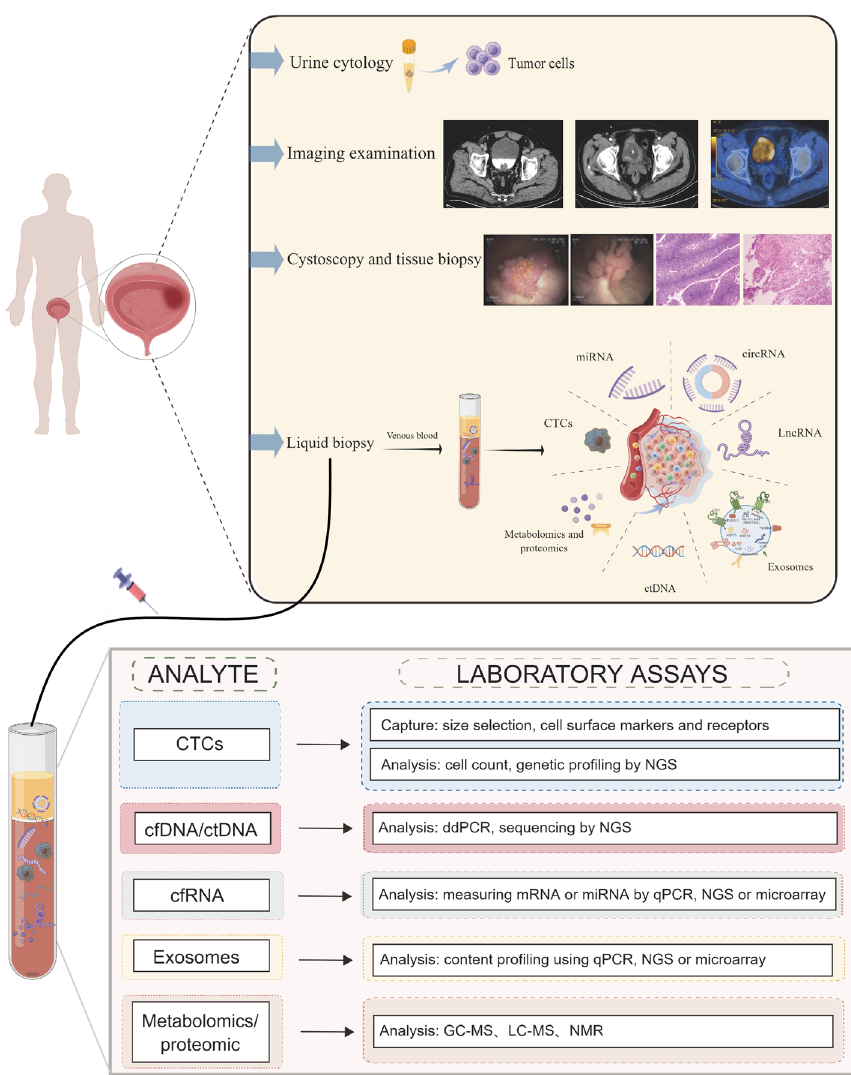
Fig. 1 Overview of clinical examination methods for bladder cancer and laboratory analytical techniques for liquid biopsies. Routine imaging tests used for bladder cancer detection and diagnosis include X-ray, CT, and PET–CT. Cystoscopy and tissue biopsy are the gold standard for the diagnosis of bladder cancer. Urine cytology is available as a complementary test. Liquid biopsy is emerging as a promising method. Liquid biopsy involves the collection and analysis of five different tumor components from peripheral blood samples: CTCs, cell-free nucleic acids (cfDNA/ctDNA, cfRNA), exosomes, and metabolomics and proteomics. Tumor components are then captured and analyzed in peripheral blood samples using appropriate laboratory assays. CT computed tomography, PET positron emission computed tomography, CTCs circulating tumor cells, ctDNA circulating tumor deoxyribonucleic acid, cfDNA cell-free DNA, cfRNA cell-free